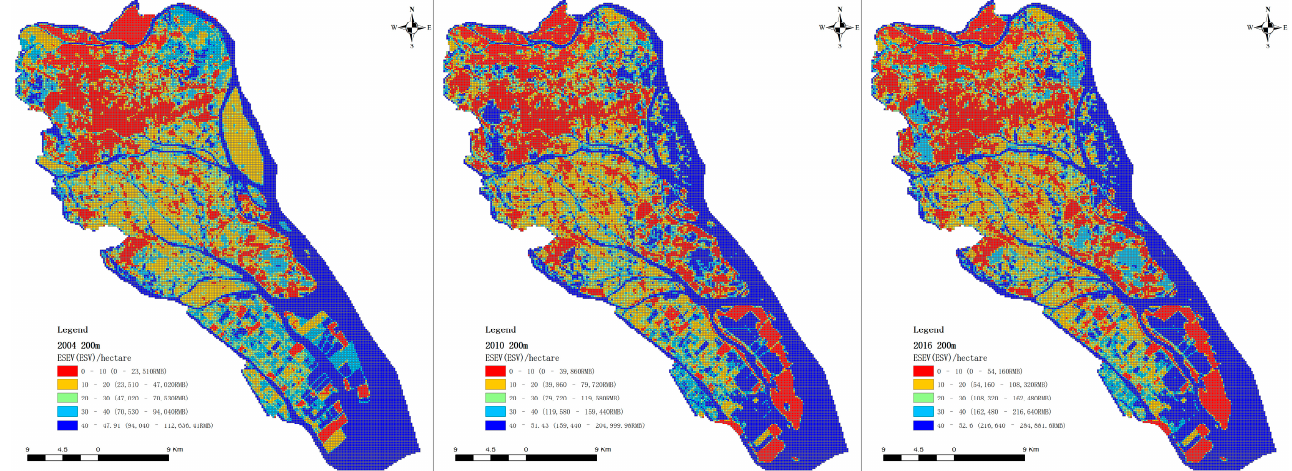
Figure 3. The special grids of the ESV (taking the 200 m scale grids as an example).